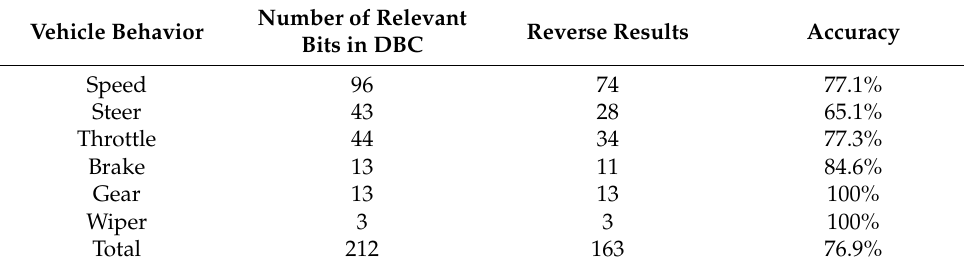
Table 7. Bit reverse result with DBC file description.